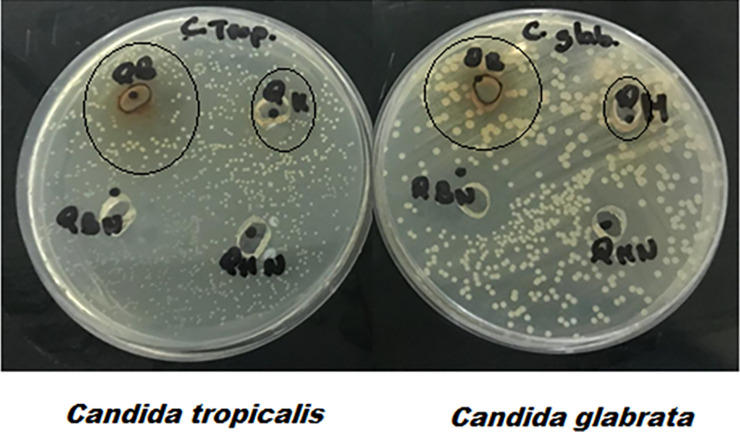
Antifungal activity of MgONPs synthesized by S. costus biomasses against C. tropicalis and C. glabrata.